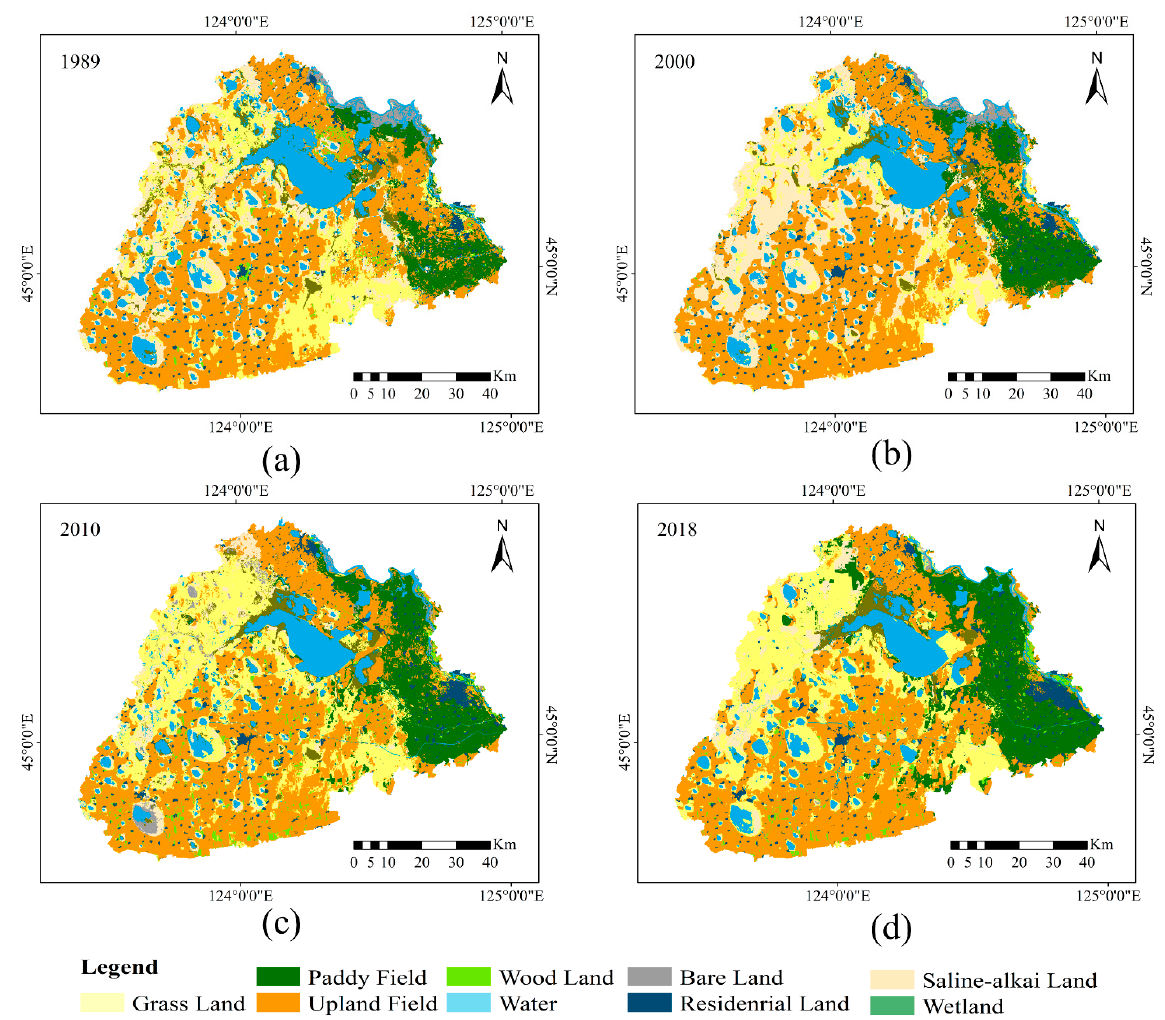
Figure 3. Spatial distribution of land use/cover for ( a ) 1989, ( b ) 2000, ( c ) 2010, and ( d ) 2018. Table 1. Land use type transfer matrix from 1989 to 2018 (km 2 ).